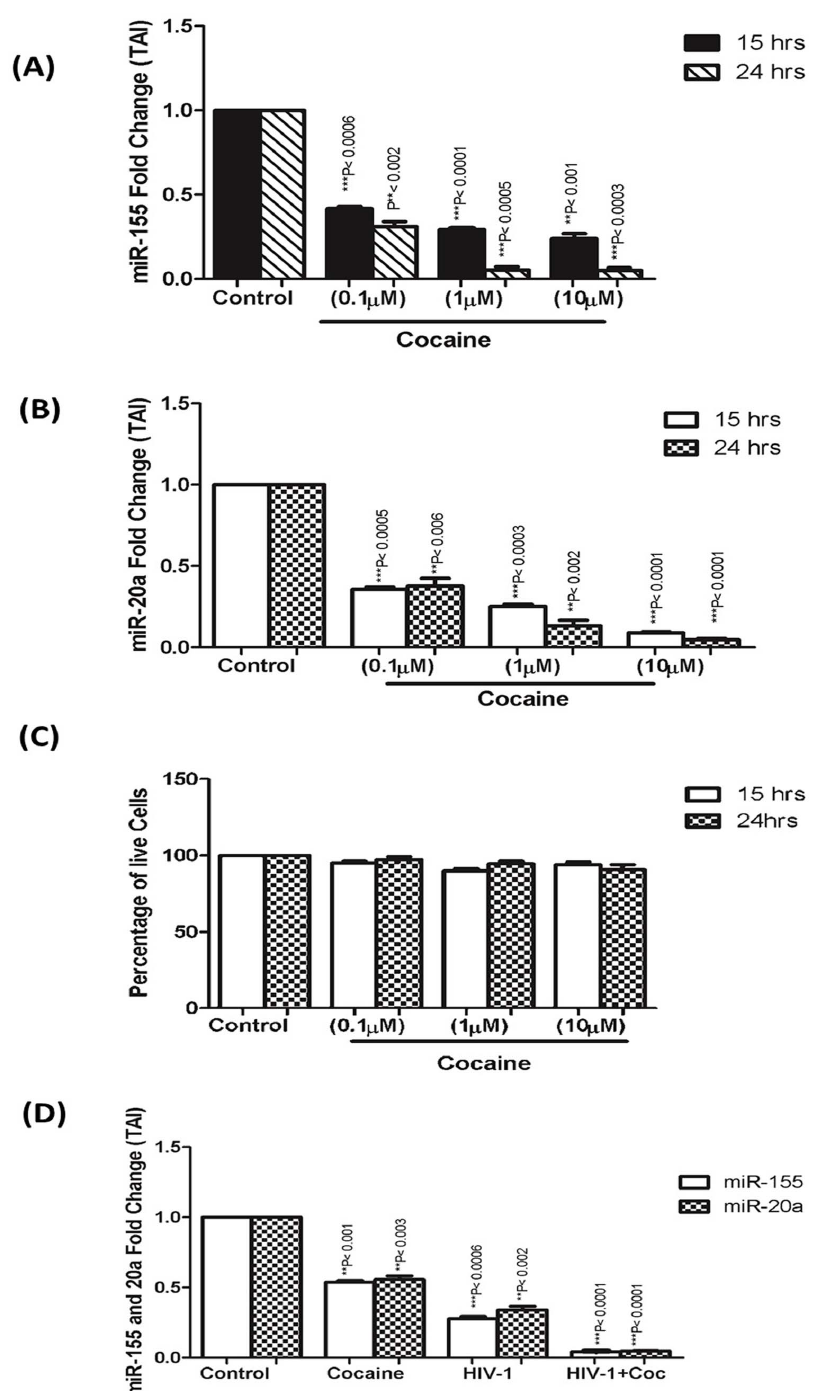
Figure 1. Cocaine and HIV synergistically down-regulate miR-155 and 20a. MDDCs (1 6 10 6 cells/ml) from normal donors were cultured with 3 different concentrations (0.1, 1 and 10 m M) of cocaine for 15 and 24 hrs.Total cellular microRNA was extracted and amplified by specific RT-PCR for miR-155 and 20a gene expression. Cocaine down regulates (A) miR-155 (B) and 20a gene expression. ( C) Cocaine treatment does not induce cytotoxicity. Cell suspension (200 m l) was subjected to XTT-PMS (100 m l) followed by a 4 hr incubation period. Cytotoxicity was measured by ELISA reader and cell suppression was calculated by: suppression index (%) = ((Abs cocaine – Abs blank)/(Abs control - Abs blank)) 6 100%. ( D ) MDDCs (1 6 10 cells/ml) from normal donors were infected with HIV-1 BAL at a concentration of 20 ng for 2 hr, followed by treatment 6 cocaine (1 m M) for 7 days. Total cellular microRNA was extracted and amplified by specific RT-PCR for miR-155 and 20a gene expression. Results shown are representative of mean 6 SEM of three experiments. Graphs are represented as % of TAI compared to the non-treated control. p-value # 0.05 were considered to be significant.